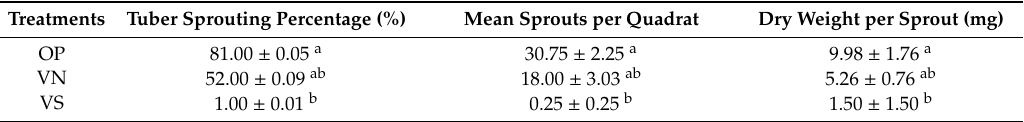
Table 4. Comparison of tuber sprouting percentage, mean sprouts per quadrat and dry weight per sprout of CR when sowed in the BPr vegetation with (VS) or without (VN) removing the shoots and litter, and in the field (mulched with an opaque plastic sheet, OP) outside the BPr vegetation as control. Treatments Tuber Sprouting Percentage (%)